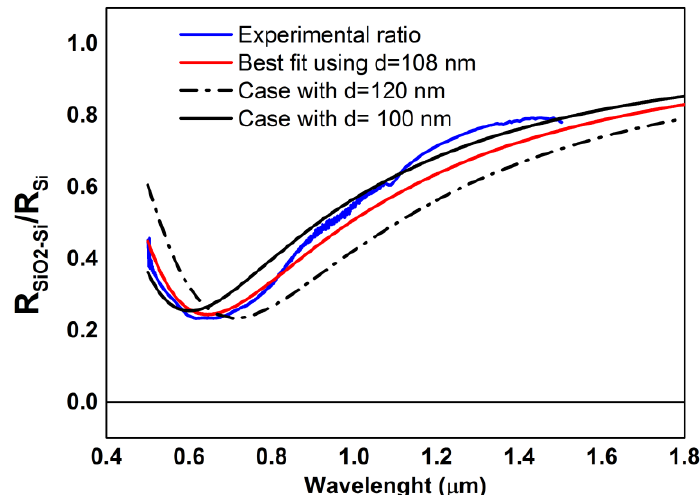
Figure 10. Silicon oxide/silicon reflectance ratio as function of wavelength. Experimental (blue line) and calculated trend for different thickness of silicon oxide layer: 108 nm (red line), 100 nm (black line), 120 nm (dotted